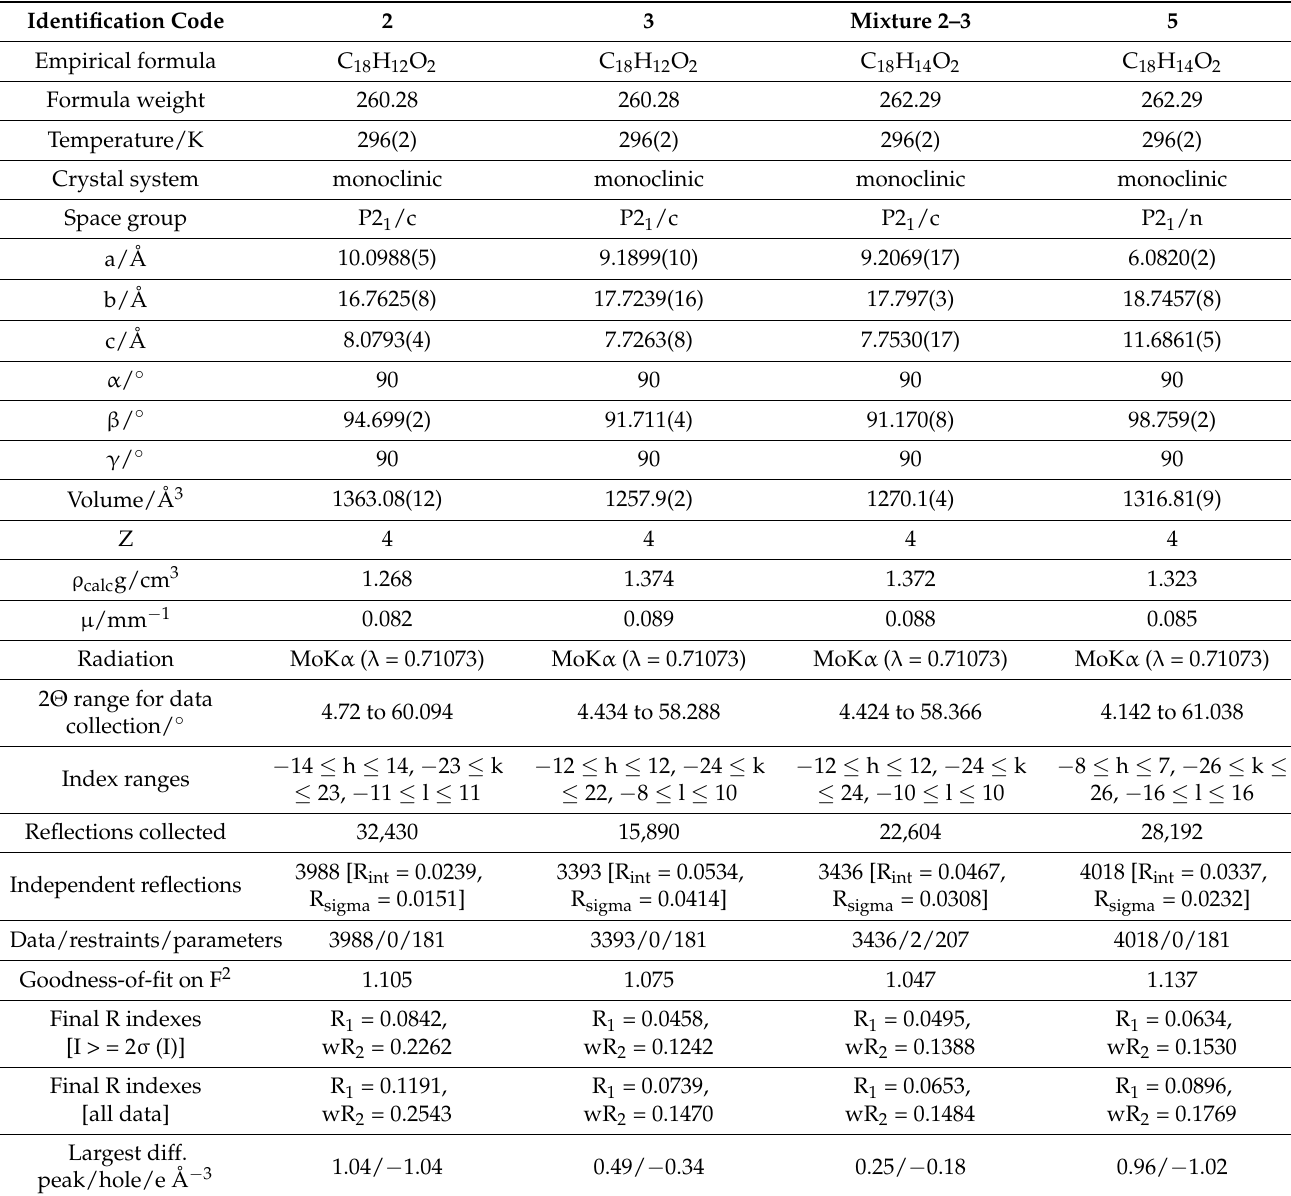
Table 1. Crystallographic data and structure refinement details for 2 , 3 , mixture 2 – 3 and 5